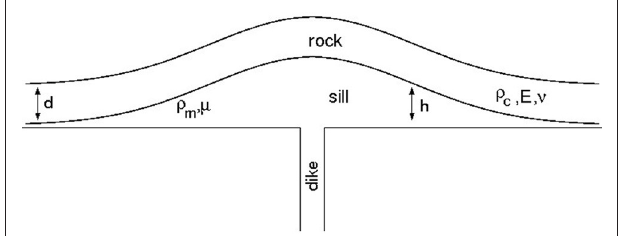
FIGURE 2 | Sketch of the sill, h is the thickness of the sill which corresponds to the uplift at the surface (not to scale), and d is the thickness of the rock. The sill is not to scale, its real thickness is much smaller than its width.